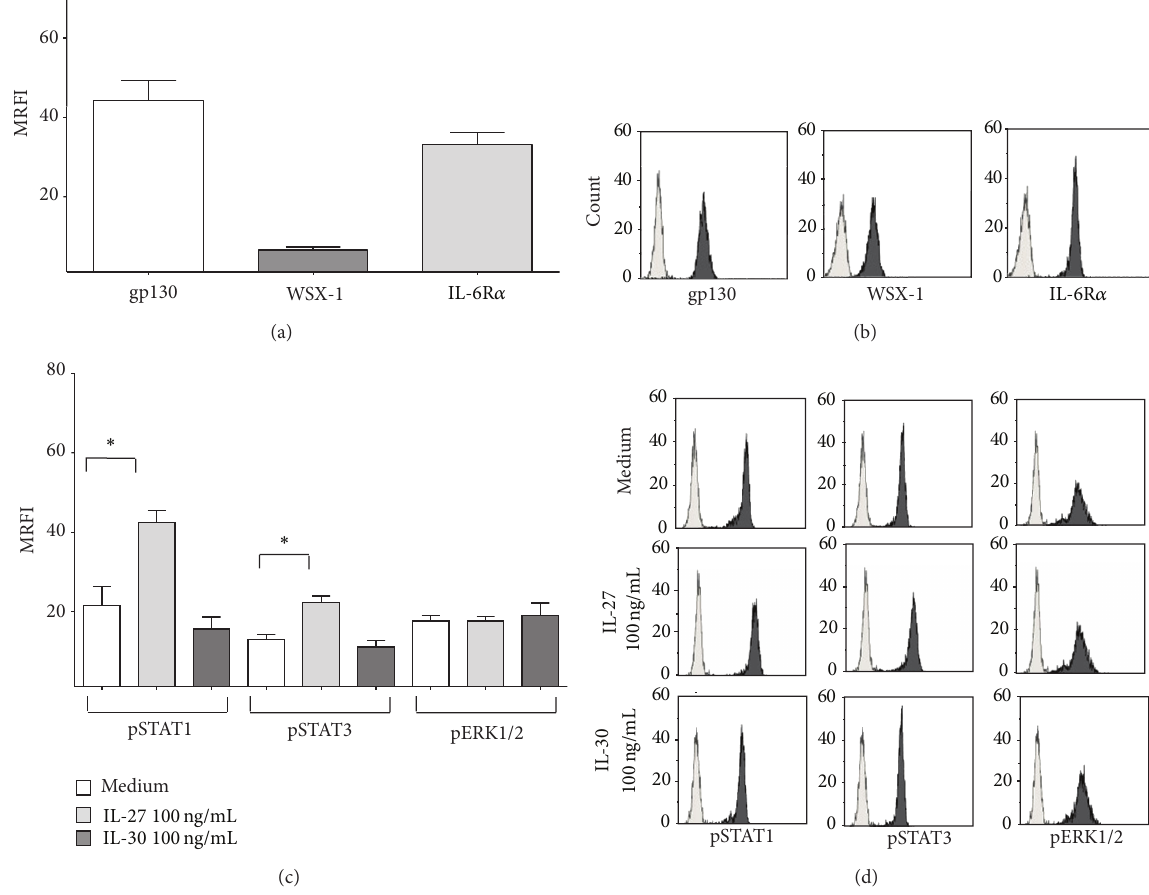
Figure 1: Expression and function of IL27R and IL30R in human monocytes. (a) Expression of gp130 (white bar), WSX-1 (grey bar), and IL6R 𝛼 (light grey bar) was evaluated by flow cytometry in freshly isolated monocytes. Results are represented as MRFI. Histograms represent mean of six different experiments ± SD. One representative FACS analysis is reported in (b). Grey profiles show staining with irrelevant fluorochrome and isotype matched mAb. Black profiles show staining with specific mAb. (c) STAT1, STAT3, and ERK1/2 phosphorylation was investigated in monocytes cultured with medium alone (white bars), 100 ng/mL IL-27 (light grey bars), or 100ng/mL IL-30 (grey bars). Results are represented as MRFI. Histograms represent mean of six different experiments ± SD. Asterisks indicate statistical significance. One representative FACS analysis is reported in (d). Grey profiles show staining with irrelevant fluorochrome and isotype matched mAb. Black profiles show staining with specific